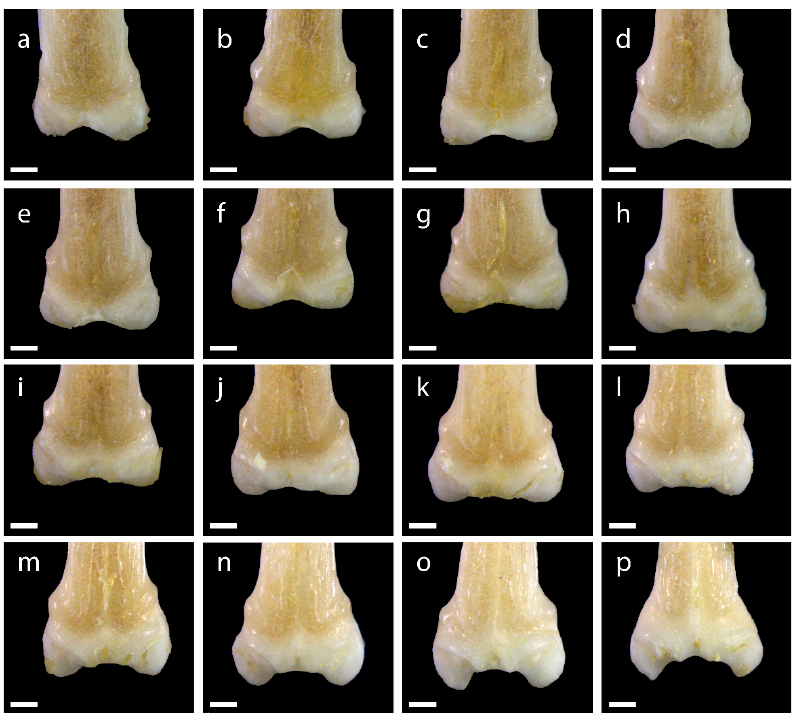
Figure A6. Microscopic images of the anterior view of the pinnules of P. bichir PO1. The images ( a – p ) correspond to the 1st, 2nd, 3rd, 4th, 5th, 6th, 7th, 8th, 9th, 10th, 11th, 12th, 13th, 14th, 15th, and 16th pinnules, respectively. Scale bars = 1 mm.